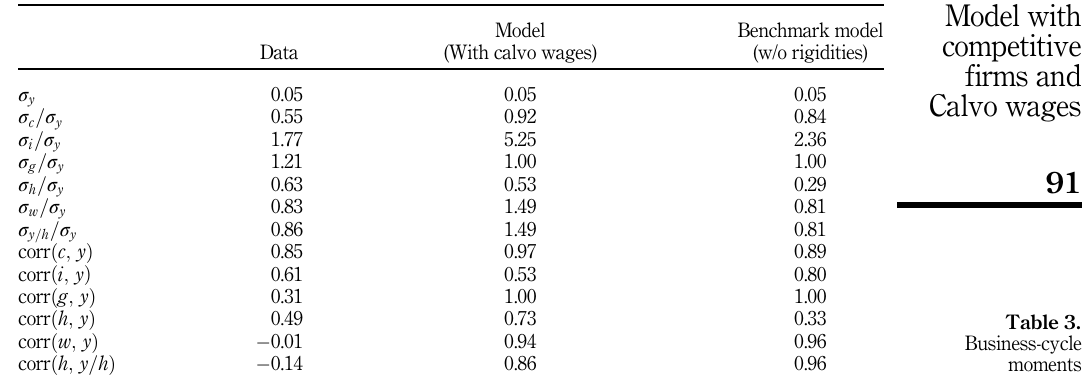
Table 3. Business-cycle